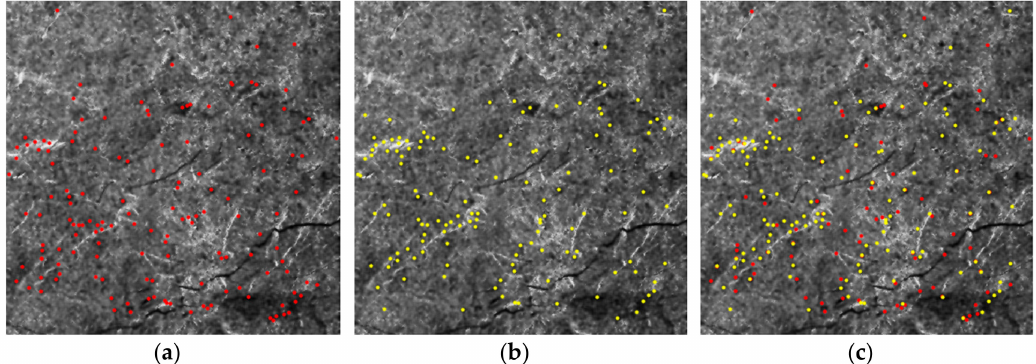
Figure 7. Comparison of successfully matched key points from ( a ) HH polarization, ( b ) HV polarization, and ( c ) HH + HV polarization. The key points are extracted from case 1.